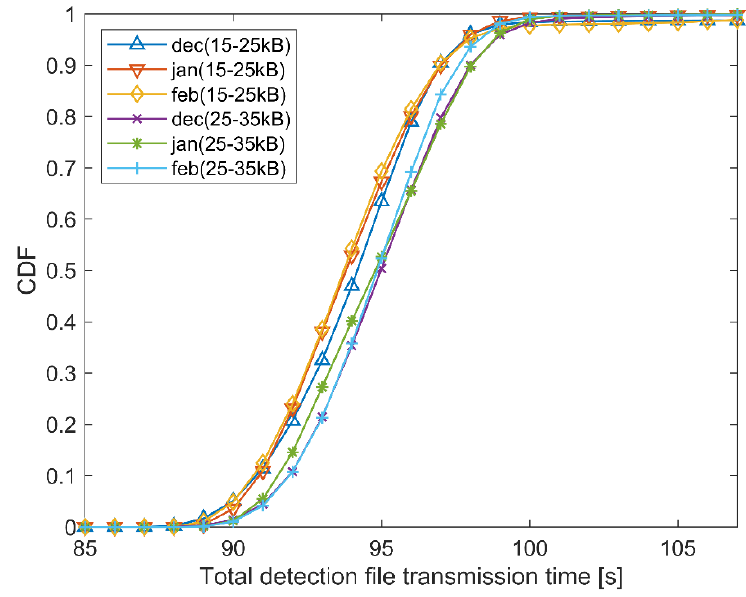
Figure 17. CDF of 15–25 kB and 25–35 kB for Dec–Feb.